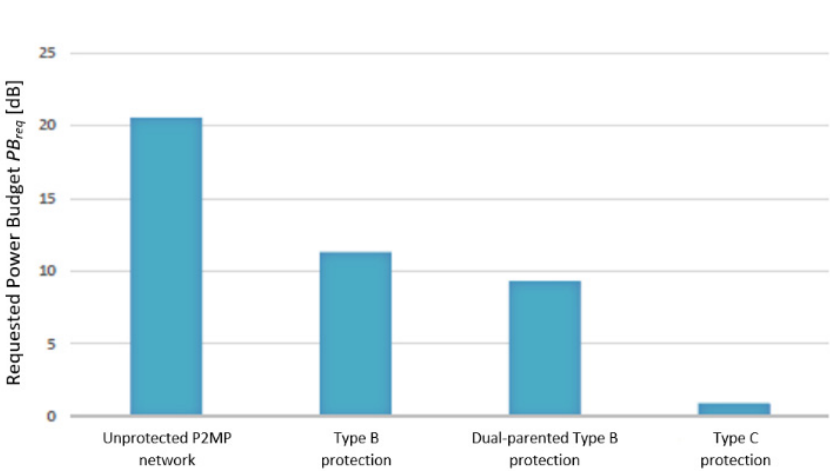
Figure 2. The comparison of power budget requirements for P2MP WDM-PON protection schemes.